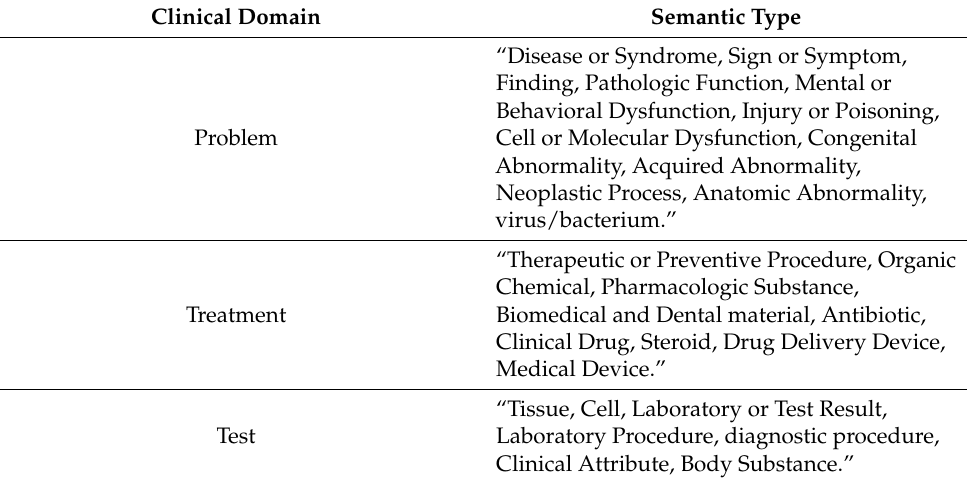
Table 1. Medical concept semantic-type dictionaries for concept